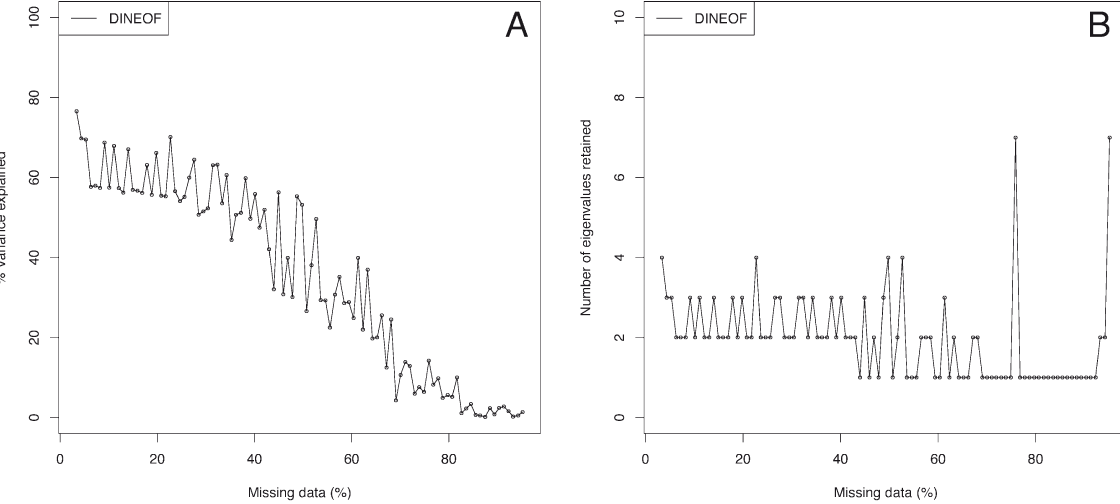
Fig . 4. – A, percentage of reconstructed variance explained; and B, number of EOFs